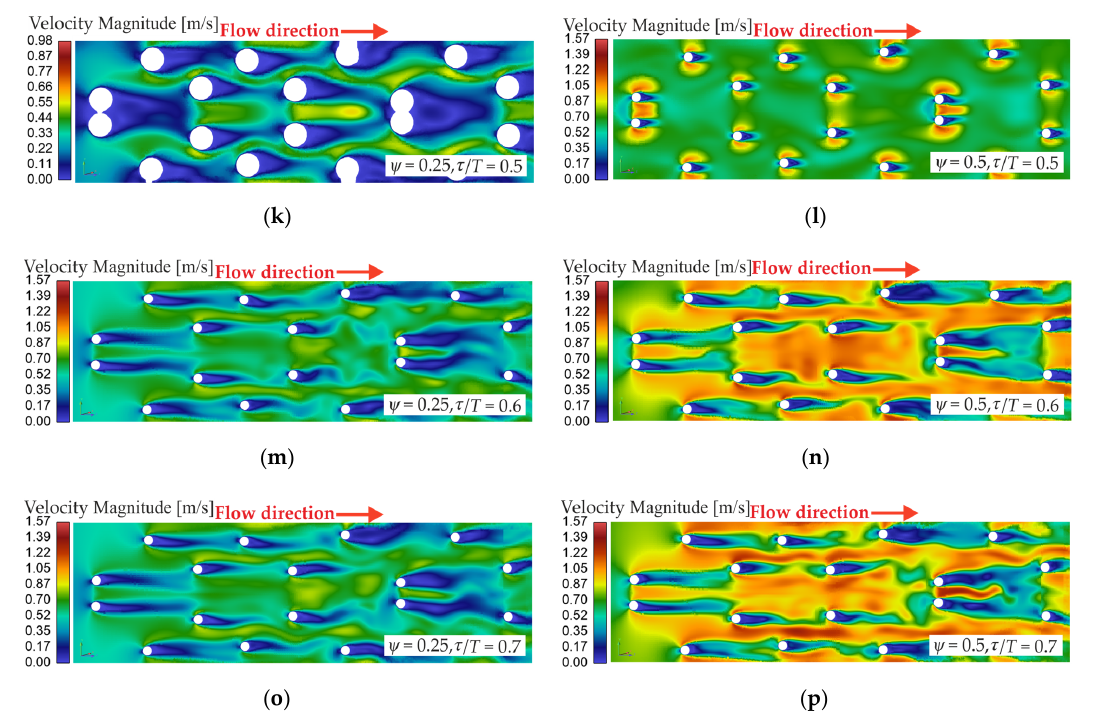
Figure 9. A cut plane of the instantaneous velocity contours plots in middle cross section for pulsating flow at ε = 0.954, Re = 25, ( A / D ) St = 0.344. Unit is m/s: ( a ) ψ = 0.25, τ / T = 0; ( b ) ψ = 0.5, τ / T = 0; ( c ) ψ = 0.25, τ / T = 0.1; ( d ) ψ = 0.5, τ / T = 0.1; ( e ) ψ = 0.25, τ / T = 0.2; ( f ) ψ = 0.5, τ / T = 0.2; ( g ) ψ = 0.25, τ / T = 0.3; ( h ) ψ = 0.5, τ / T = 0.3; ( i ) ψ = 0.25, τ / T = 0.4; ( j ) ψ = 0.5, τ / T = 0.4; ( k ) ψ = 0.25, τ / T = 0.5; ( l ) ψ = 0.5, τ / T = 0.5; ( m ) ψ = 0.25, τ / T = 0.6; ( n ) ψ = 0.5, τ / T = 0.6; ( o ) ψ = 0.25, τ / T = 0.7; ( p ) ψ = 0.5, τ / T = 0.7.